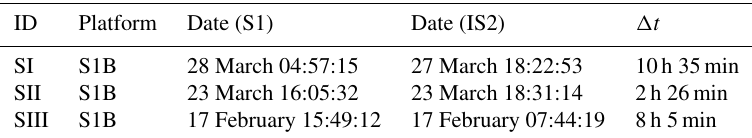
Table 1. Sentinel-1 (S1) frames utilised in this study with ID number for comparison with cases and dates for acquisition for both S1 and ICESat-2 (IS2); see Table 3. Dates are provided in the UTC time frame.